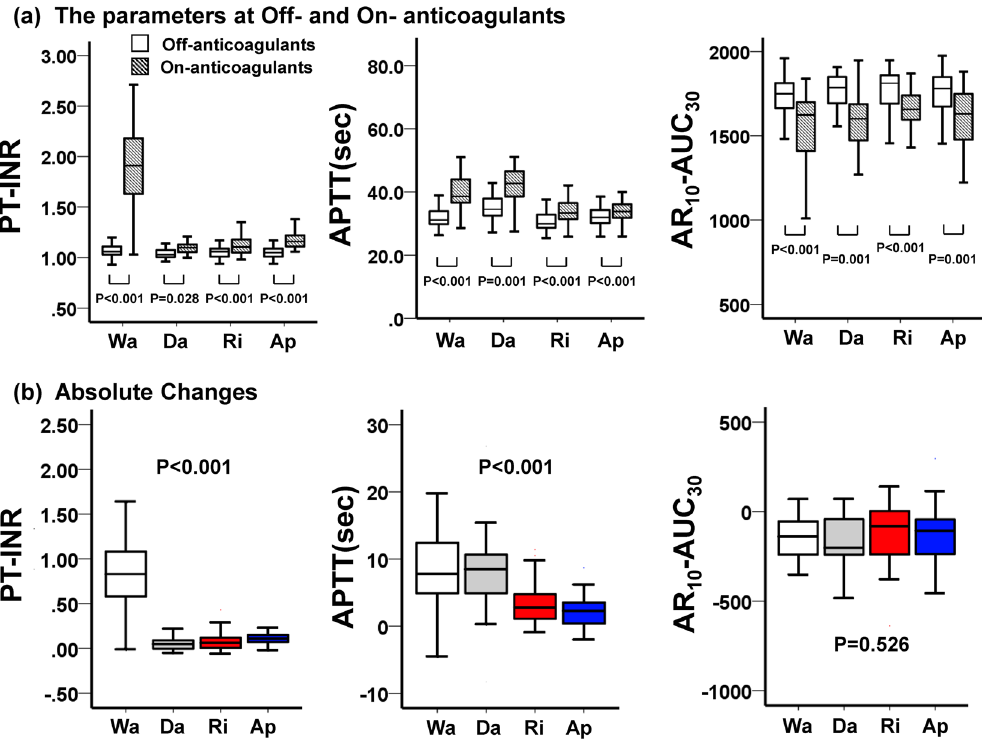
Figure 3. Quantitative analysis of various parameters at Off- and On-anticoagulants. In these box-and-whisker plots, lines within the boxes represent median values; the upper and lower lines of the boxes represent the 25th and 75th percentiles, respectively; and the upper and lower bars outside the boxes represent maximum and minimum values, respectively. Wa = warfarin, Da = dabigatran, Ri = rivaroxaban, Ap = apixaban